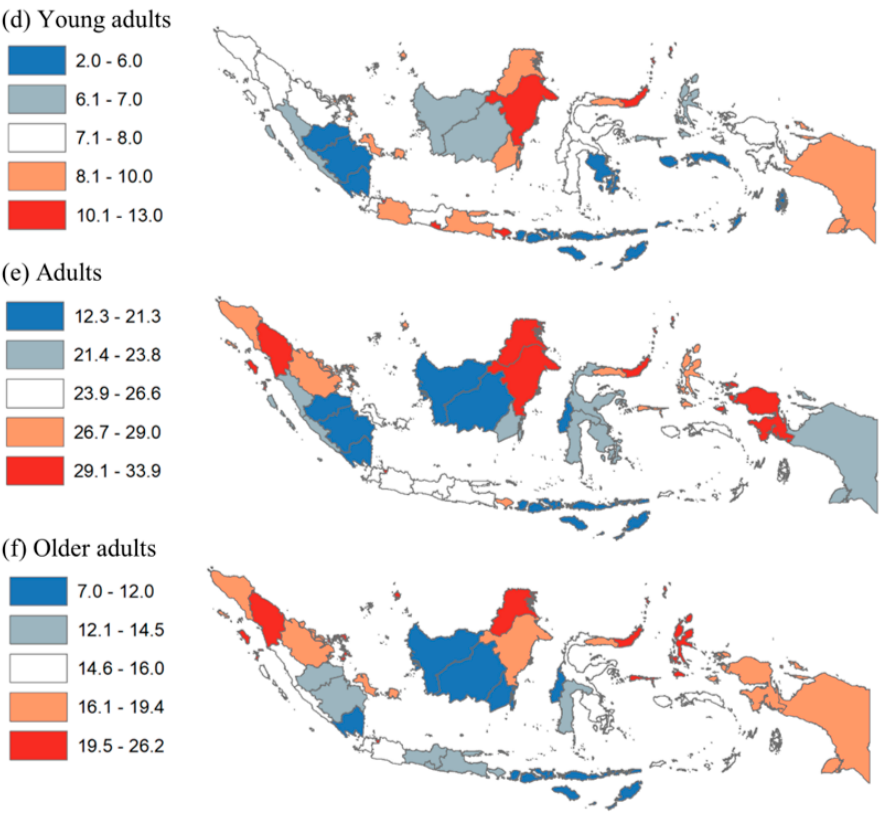
Figure 2. Disparity of obesity among adults by province in Indonesia, 2018. Note: Numbers show prevalence of obesity among all adults, males, females, young adults, adults, and older adults. For socioeconomic disparities, the prevalence of obesity by income at the province level is shown in Table 1. The top box shows the wealthiest provinces (including Bali, Jakarta, North Kalimantan, and Riau Islands) and the bottom box shows the poorest provinces (including Maluku, East Nusa Tenggara, and West Papua). The grey-shaded prevalence shows higher than the national average in each column. Among the ten wealthiest provinces, five had consistently higher than the national average for every obesity indicator (i.e., Jakarta, North Kalimantan, East Kalimantan, and Riau Islands). In contrast, among the ten poorest provinces, only two did (i.e., Gorontalo and West Papua). Table 1. Prevalence of obesity among adults by province in Indonesia, 2018.